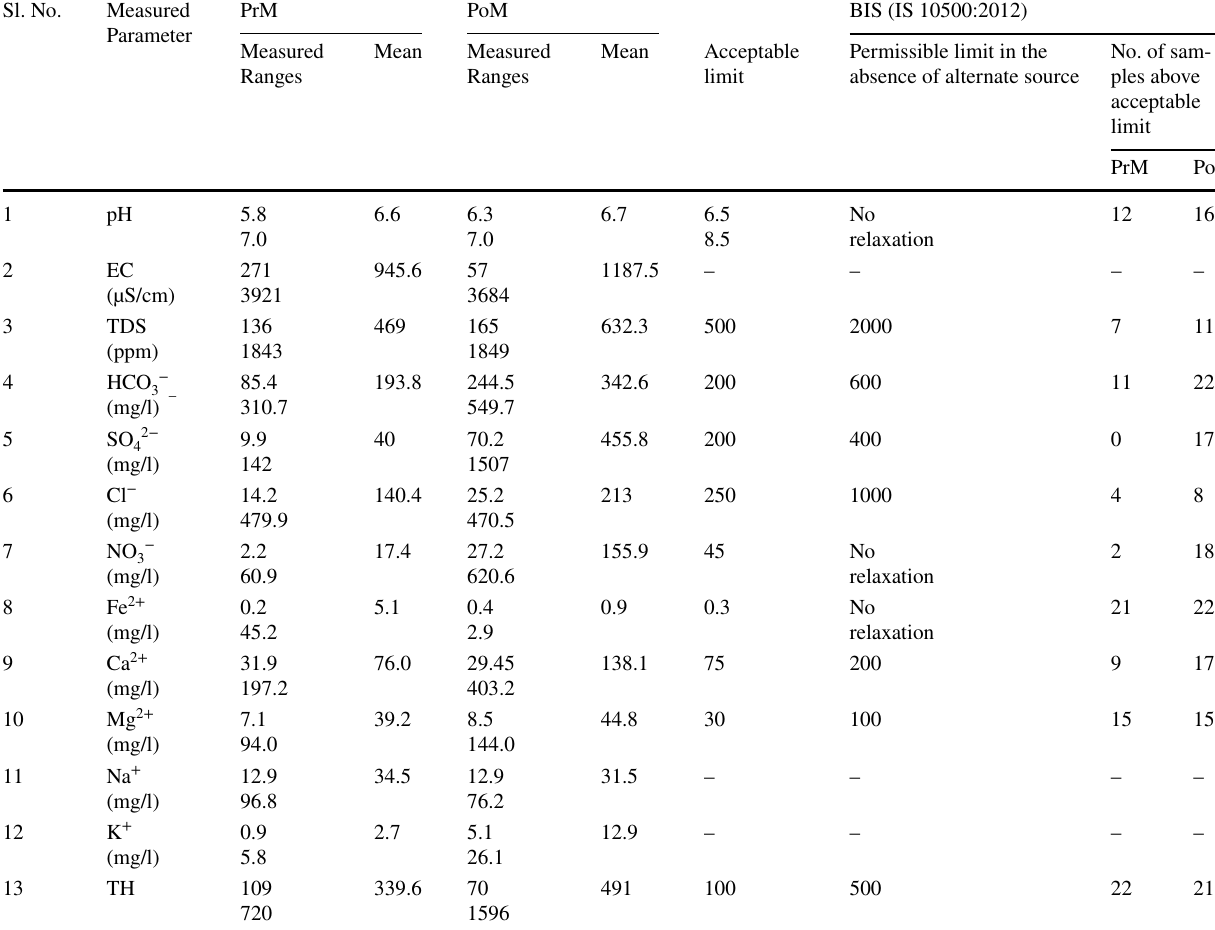
Table 4 Ranges of physicochemical parameters of groundwater and comparative status Sl.